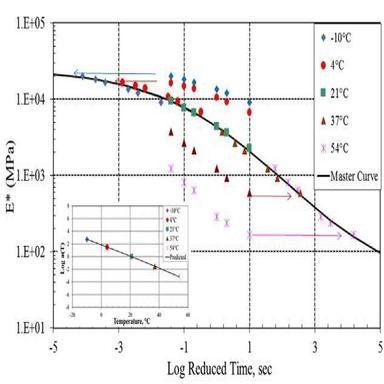
Developing Master Curve of Dynamic Modulus for an Asphalt Mix.